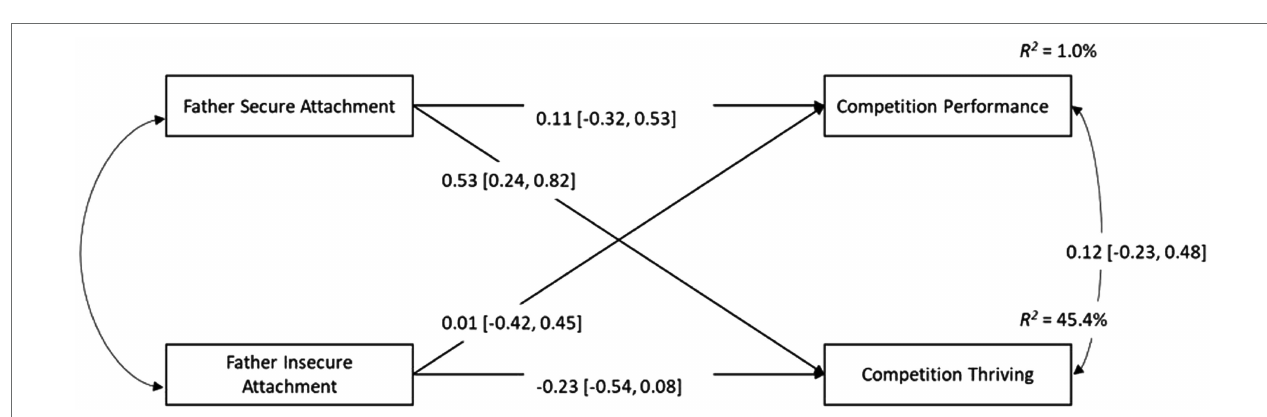
FIGURE 2 | Manifest path model displaying the relationships between mother secure attachment, mother insecure attachment, competition performance, and competition thriving. Standardized parameter estimates are displayed with the 95% confidence interval in parentheses.